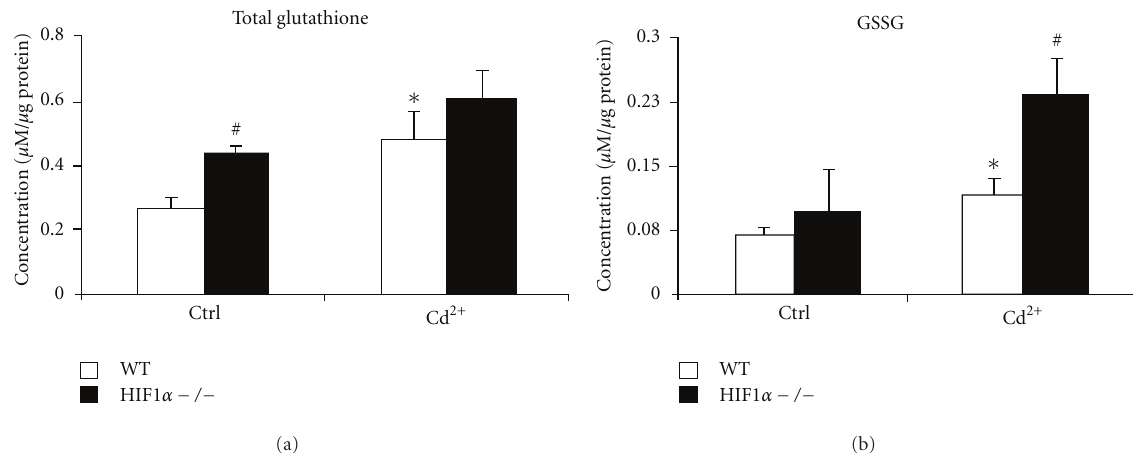
Figure 6: Cellular glutathione levels under CdCl 2 treatment. Total cellular glutathione levels (a) and reduced glutathione levels (b) in wild- type (WT, white bars) and HIF1 α − / − (black bars) cells were determined. Cells were left untreated (Ctrl), or treated with 5 μ M CdCl 2 (Cd 2+ ) for 24 hours. ∗ P < 0 . 05 compared to respective controls, n = 4. # P < 0 . 05, significant compared to wild-type cells, n =